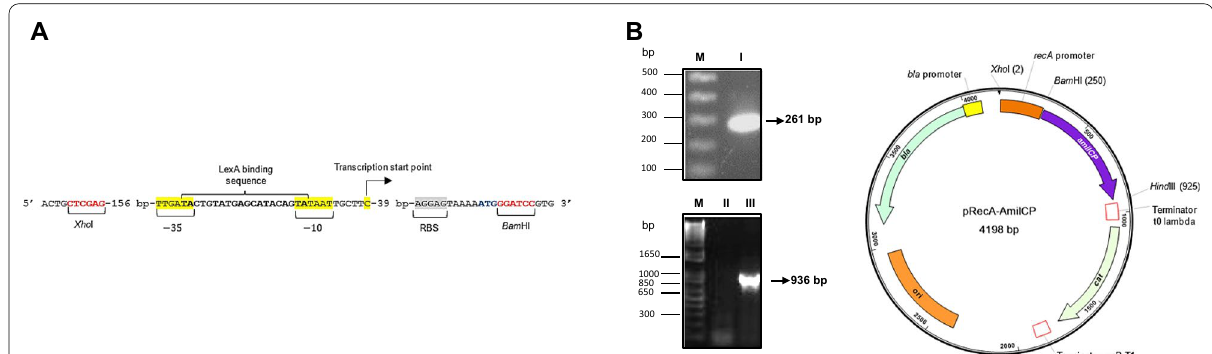
Fig. 1 Reporter plasmid map used in this study. A elements present in the recA promoter sequence used. B plasmid map and PCR confirmation of the insert of the promoter sequence (261 bp amplicon) and promoter and AmilCP coding sequence PCR verification (936 bp PCR amplicon). Restriction sites are indicated and in parenthesis the site of cleavage